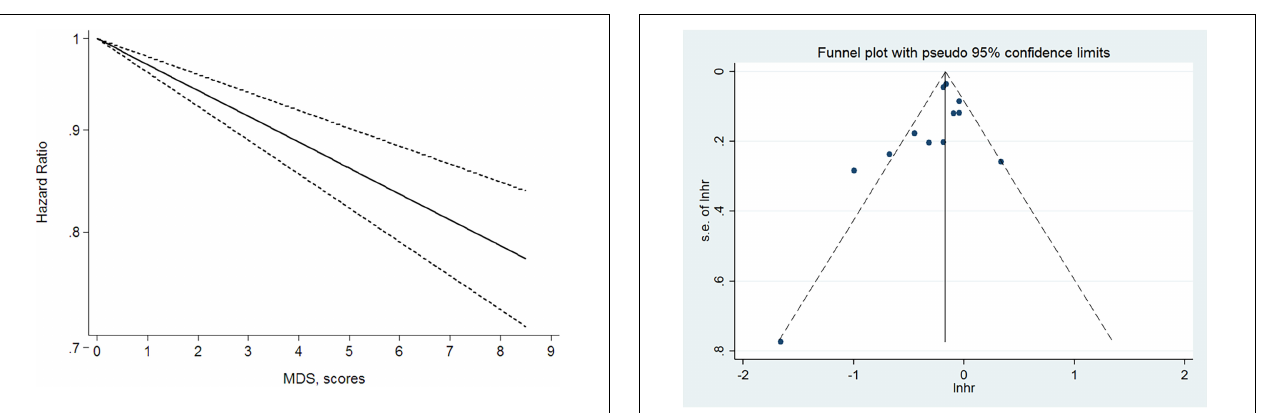
FIGURE 3 | Dose–response metaanalysis of the Mediterranean diet patterns and lung cancer risk. FIGURE 4 | Analysis of publication bias between the Mediterranean diet patterns and lung cancer